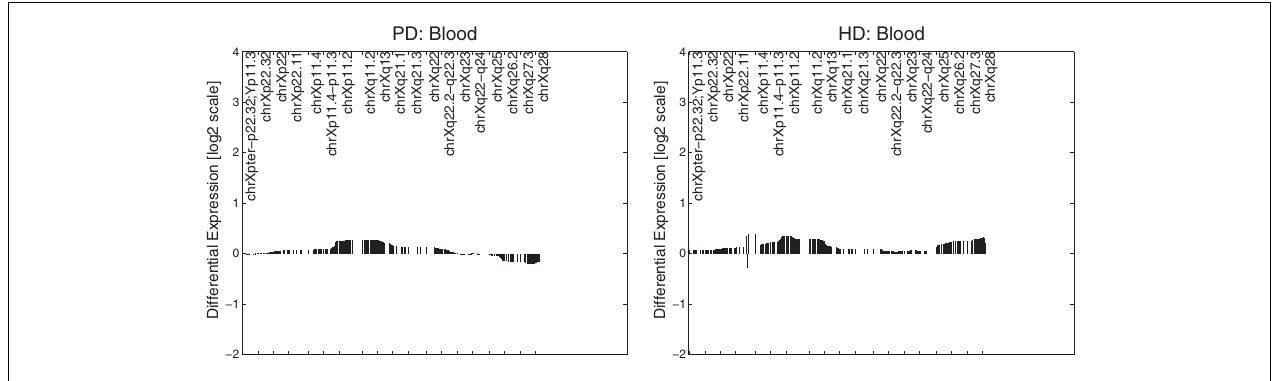
FIGURE 2 | Primary expression pattern from PD blood (left) and HD blood (right) datasets. Profiles were not associated with neuronal reporter genes and are visually different from each other and those obtained from brain tissue.